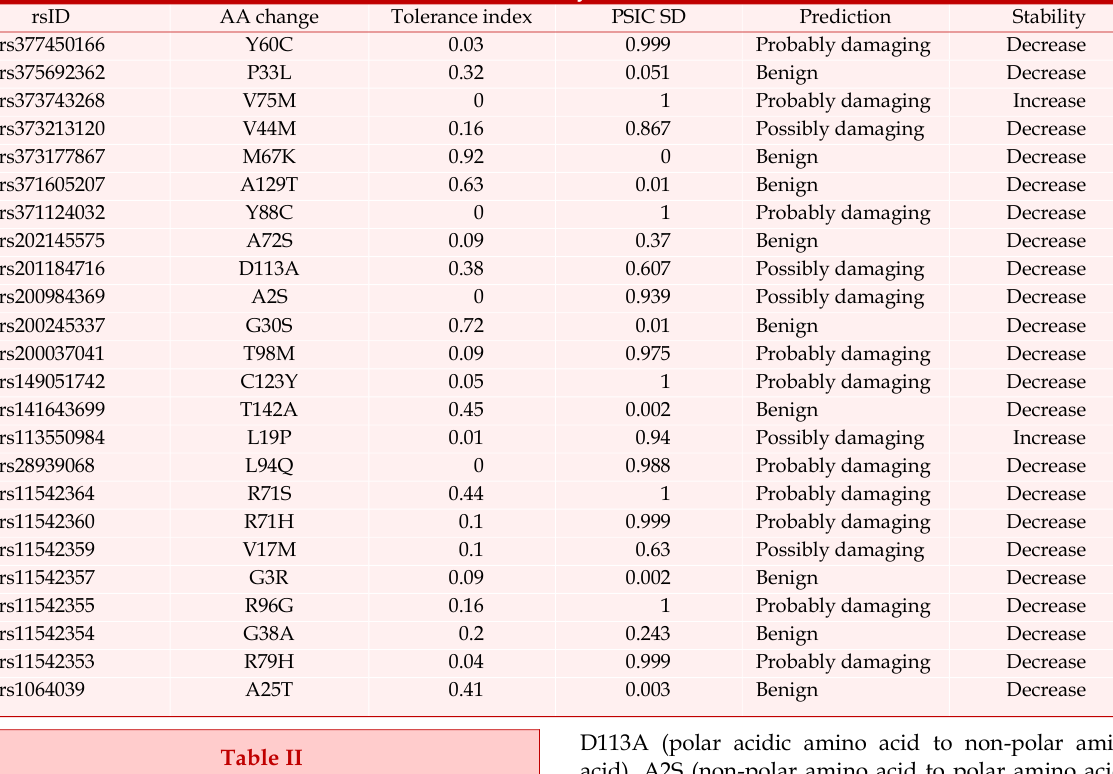
List of nsSNP predicted as deleterious, damaging and less stable by SIFT, PolyPhen-2 and I-Mutant respec-